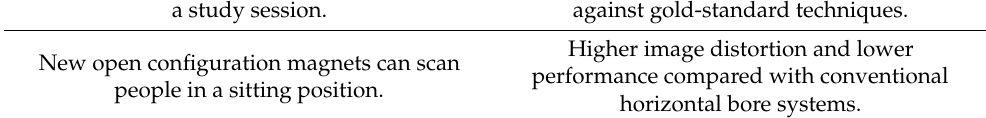
Table 2. Advantages and limitations of magnetic resonance imaging. Advantages Limitations Non-invasive. Unsuitable for patients with metal implants. Use of non-ionizing radiation. High instrumentation cost. Good quality cross-sectional images. Susceptible to motion. Richness of soft tissue contrast. Amount of data acquired can be a burden. Acquisition of different parameters within Lack of standardization and/or validation a study session. against gold-standard